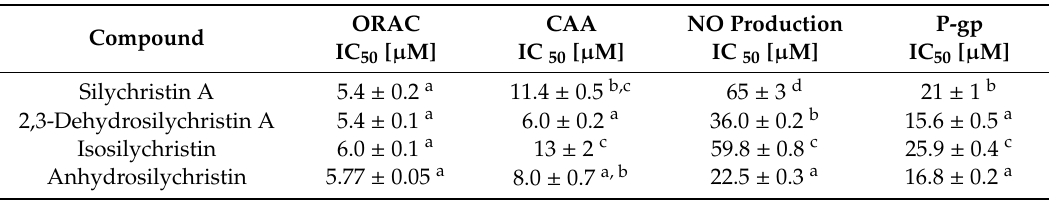
Table 1. Concentration [µM] that halved the antioxidant, anti-inflammatory and efflux pump modulating activity (IC 50 ) of silychristin and its derivatives.